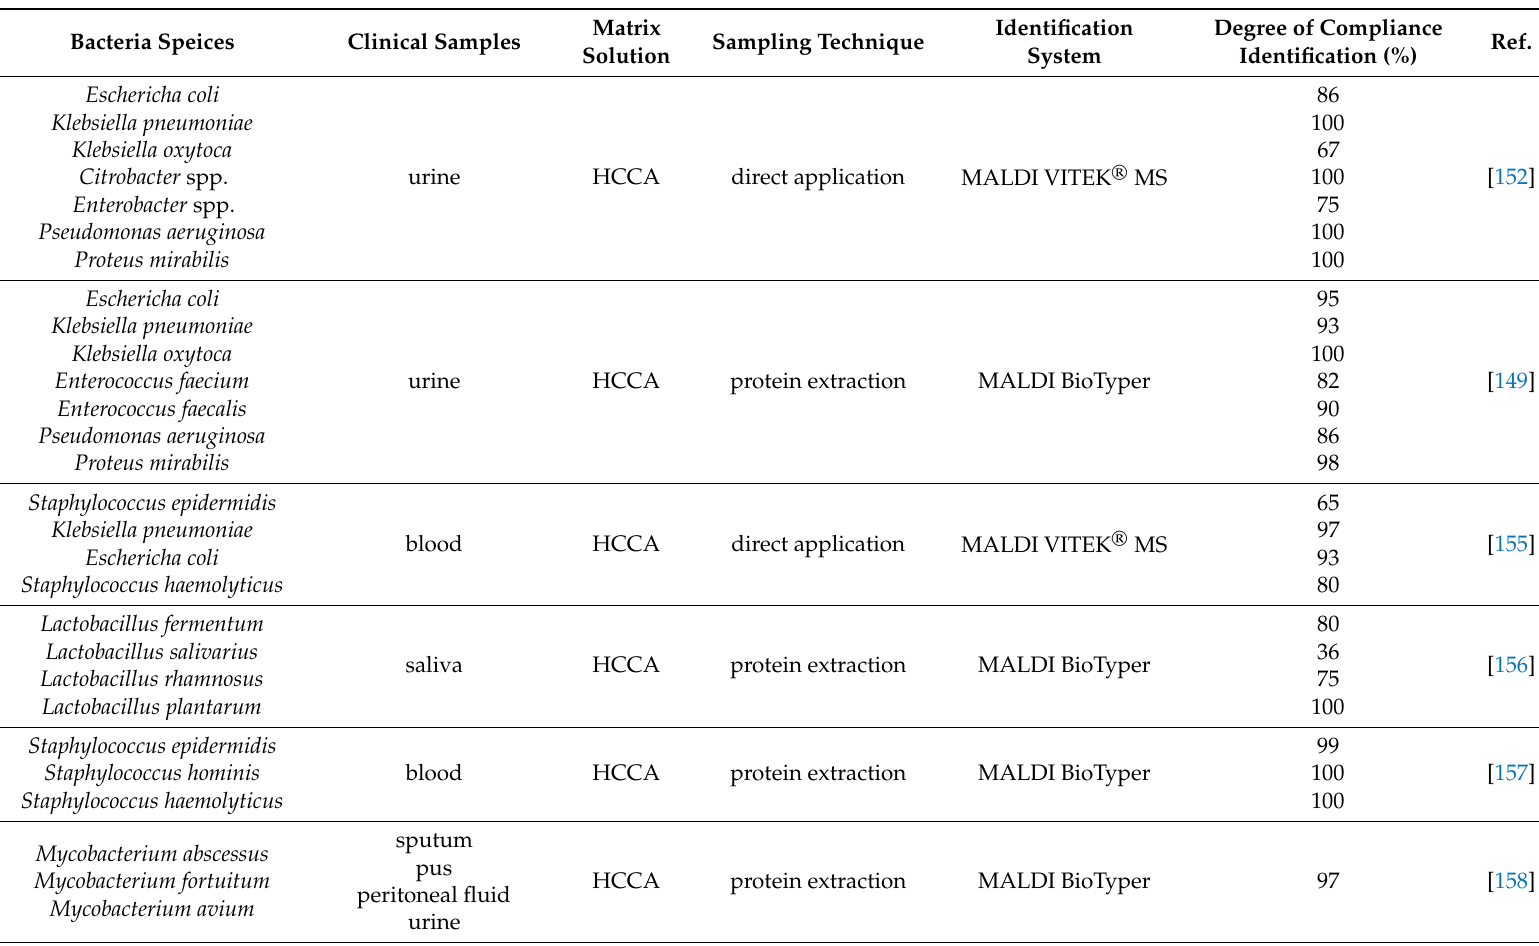
Table 4. Data of bacterial isolates from various clinical materials determination by MALDI-TOF